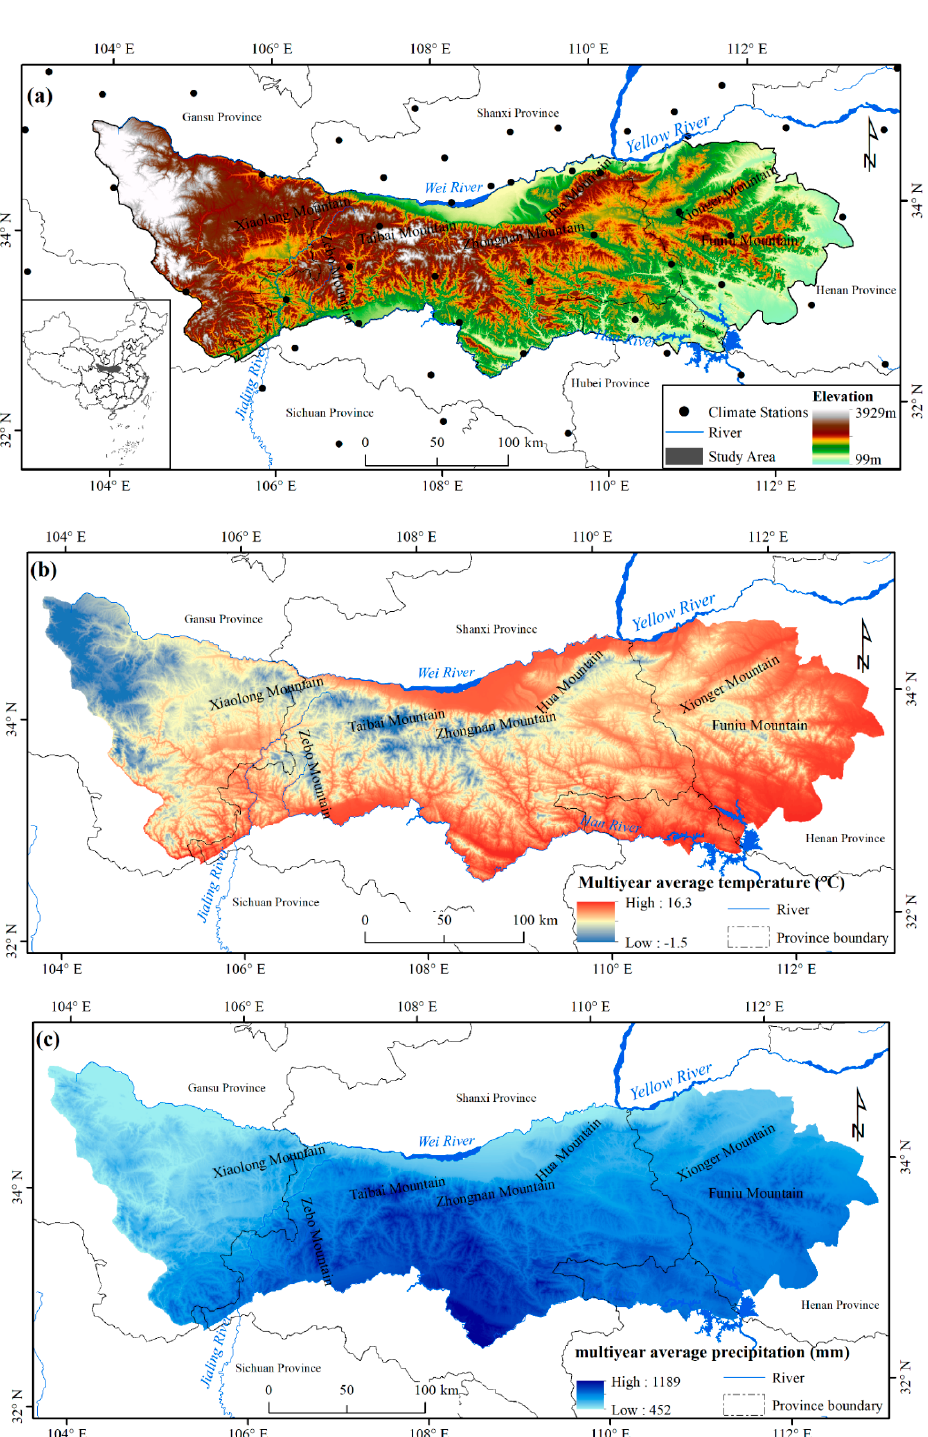
Figure 1. Geographic location and topography of the study area ( a ), the spatial distribution of the multiyear average temperature ( b ), and multiyear average precipitation ( c